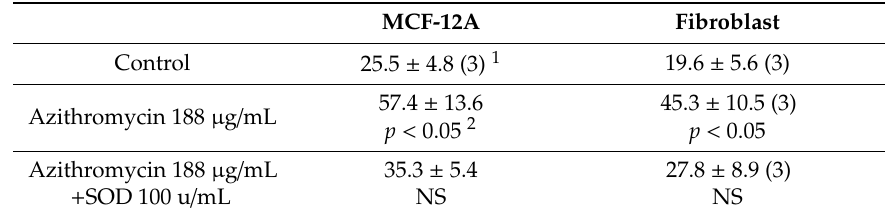
Fluorescent intensity of mitochondrial superoxide in MCF-12A cells and fibroblasts (3 h of incubation). Mitochondrial superoxide was detected by MitoSOX red mitochondrial superoxide